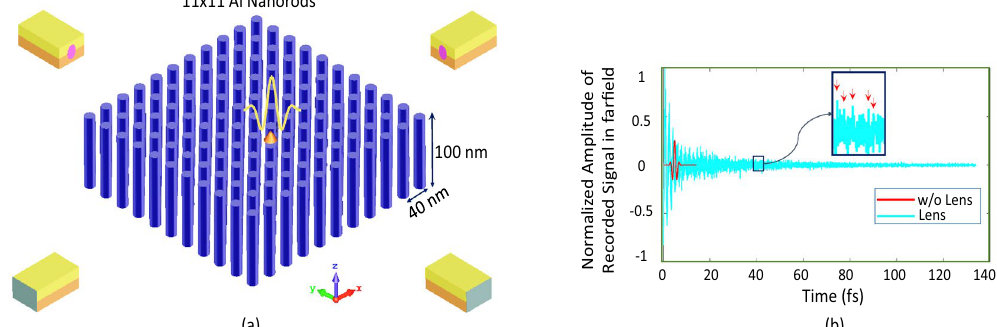
Figure 2. Nanorod lens ( a ) 11 × 11 square lattice of Al nanorod with four optical transducers. ( b ) recorded field in the far field of structure, when a short 10-fs pulse illuminates the lens in comparison to the absence of